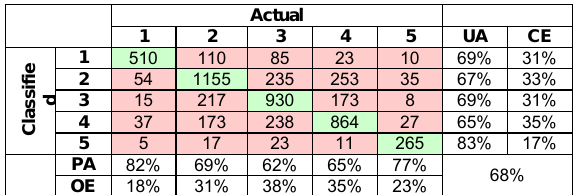
Table 2. Multiclass confusion matrix (Example data are taken from Campbell, 1996)